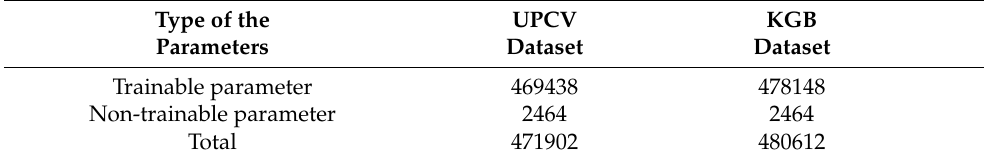
Table 9. Parameter count of the KinectGaitNet.